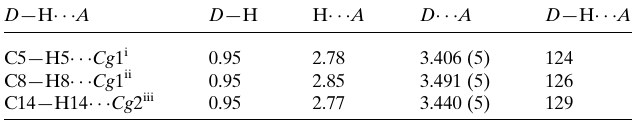
Table 1 Hydrogen-bond geometry (A˚ , (cid:2) ).